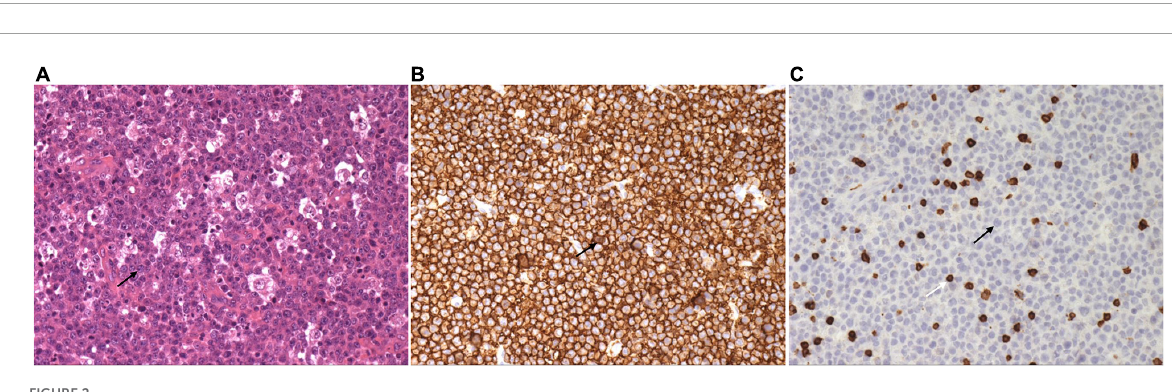
FIGURE2 Left inguinal lymph node biopsy shows diffuse large B-cell lymphoma. (A) Large, round, or ovoid tumor cells are seen, with some cells having an irregularly shaped nuclear membrane. Single large or multiple small nucleoli can be seen in the tumor cells, and nuclear division is more common (H and E, × 200). (B) Immunohistochemistry stain of CD 20 shows the tumor cells were uniformly and strongly positive ( × 200). (C) Immunohistochemistry stain of CD 3 shows the tumor cells are negative, but the T lymphocytes in the background are positive ( × 200). Black arrow indicates the tumor cell. White arrow indicates the T